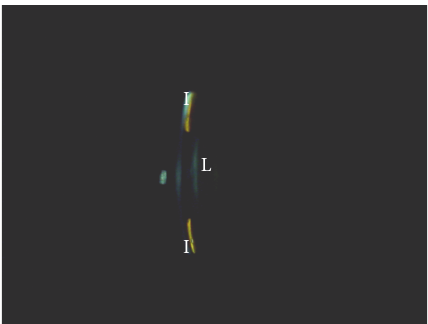
Figure 1: Photo slit camera image of the anterior segment of the left eye. The anterior surface of the lens (L) is in touch with the pos- terior surface of the iris (I), causing pupillary block thus causing intraocular pressure raise.